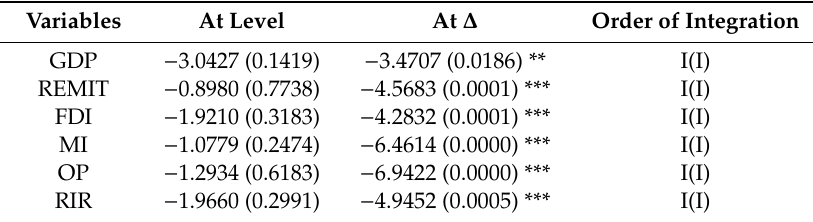
Table 3. Unit root test (augmented Dickey-Fuller test).